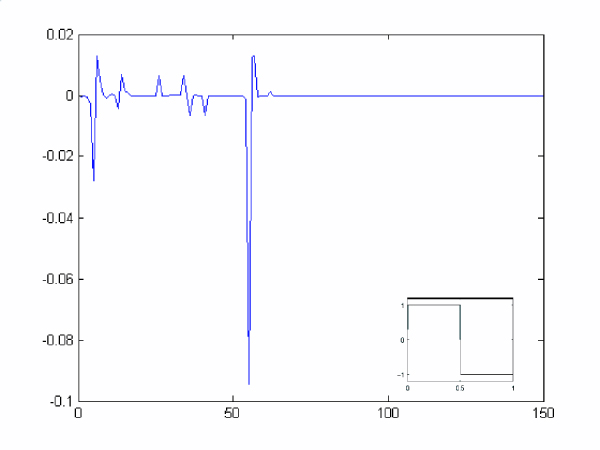
Features obtained for an 8GC hairpin after applying a Haar wavelet filter.